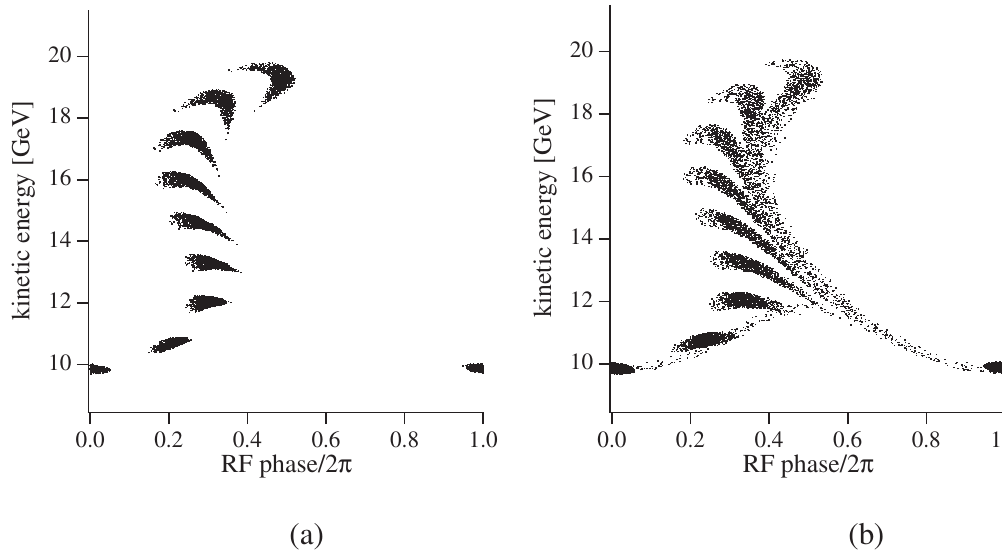
FIG. 4. Longitudinal emittance evolution with different initial distribution. (a) starts from 6D ellipsoidal distribution and (b) starts from uncorrelated distribution in horizontal, vertical, and longitudinal planes.